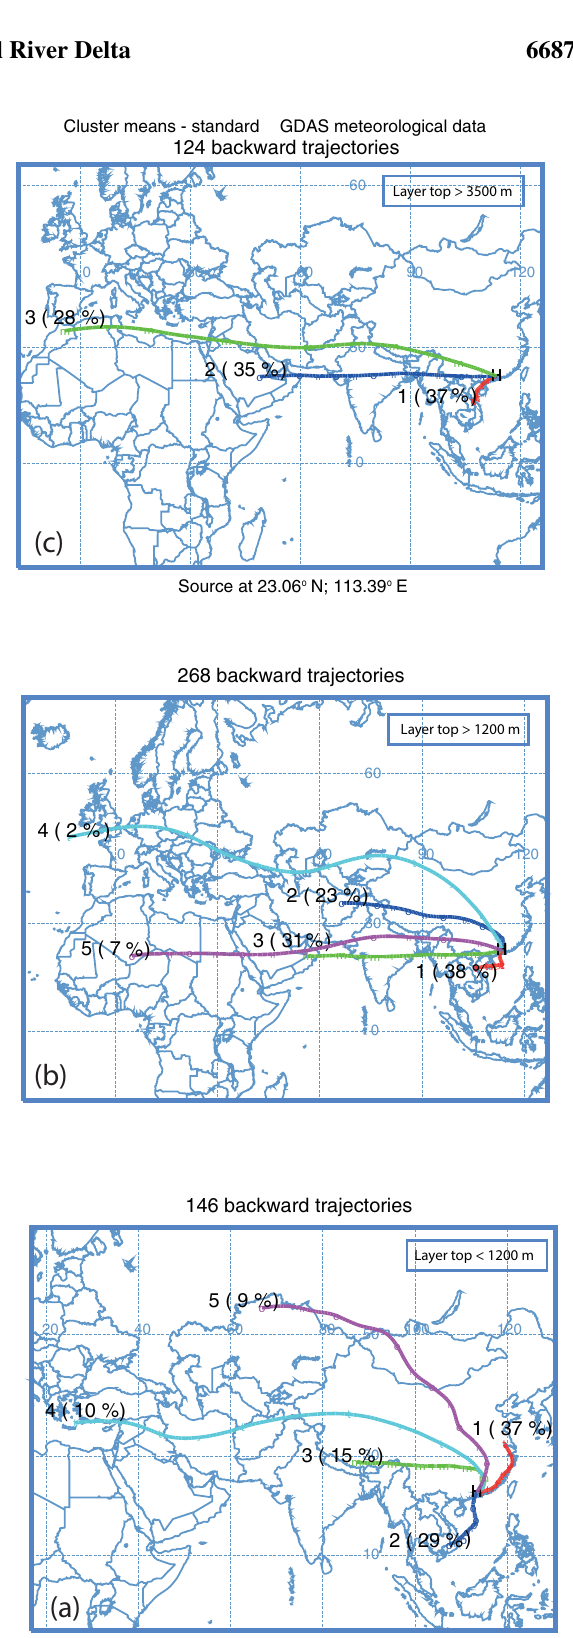
Figure 8. Trajectory cluster means for (a) PBL top heights up to 1200m, (b) all lofted layers above 1200m, and (c) lofted layers with top height above 3500m. All trajectories were calculated 144h back in